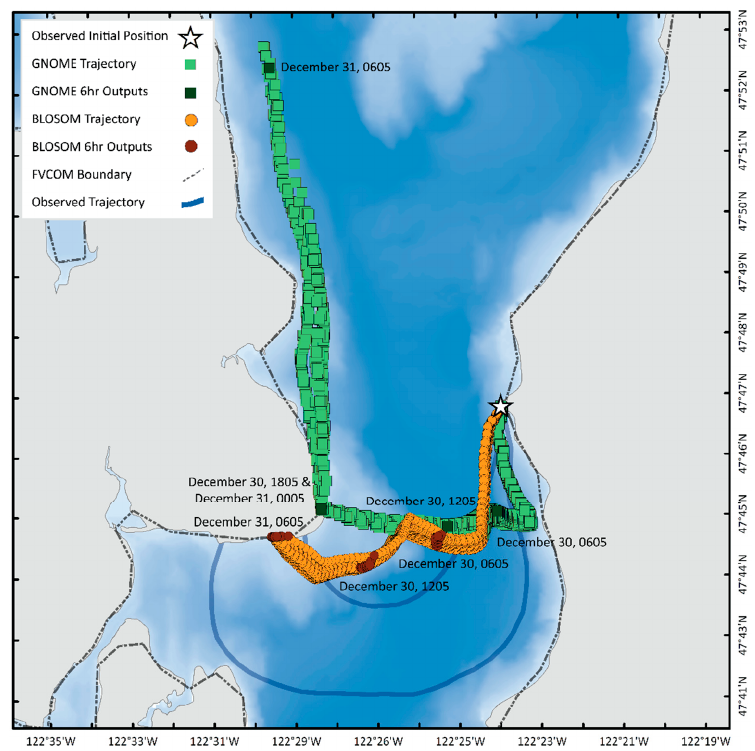
Figure A1. GNOME and BLOSOM simulations using a 1 min time step. This simulation includes 6% wind, ocean currents and some diffusion. J. Mar. Sci. Eng. 2018 , 6 , x